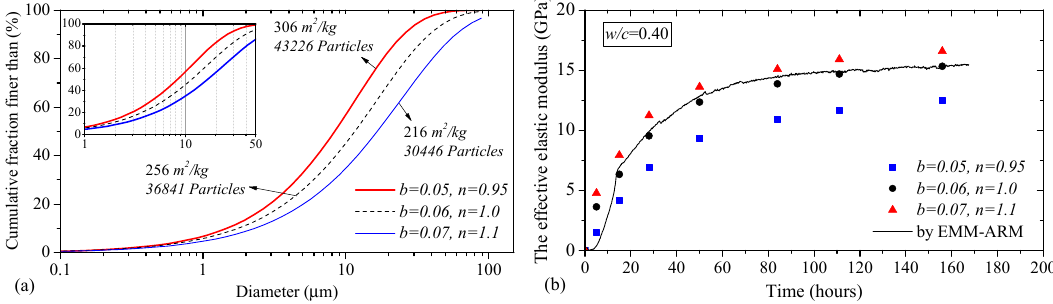
Figure 14. ( a ) Three adopted PSD curves in the hydration model by HYMOSTRUC3D; ( b ) Young’s moduli obtained for the three different PSD curves.